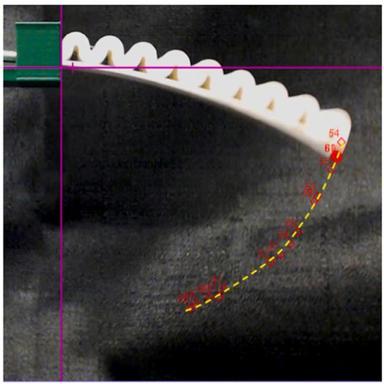
Dynamic displacement analysis for the sinusoidal signal under 10 psi, 1.5 Hz, and unloaded condition. The trajectory of the tip of the actuator is described by the yellow dotted line.